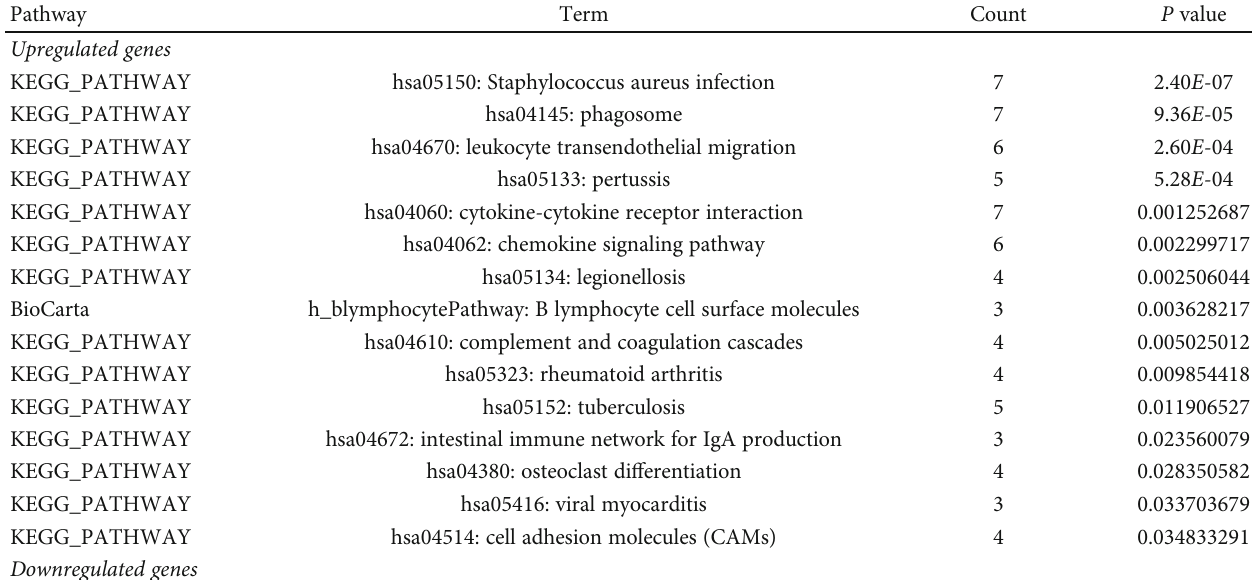
Table 3: The signi fi cant signal pathways of di ff erentially expressed genes (DEGs). Pathway Term Count P